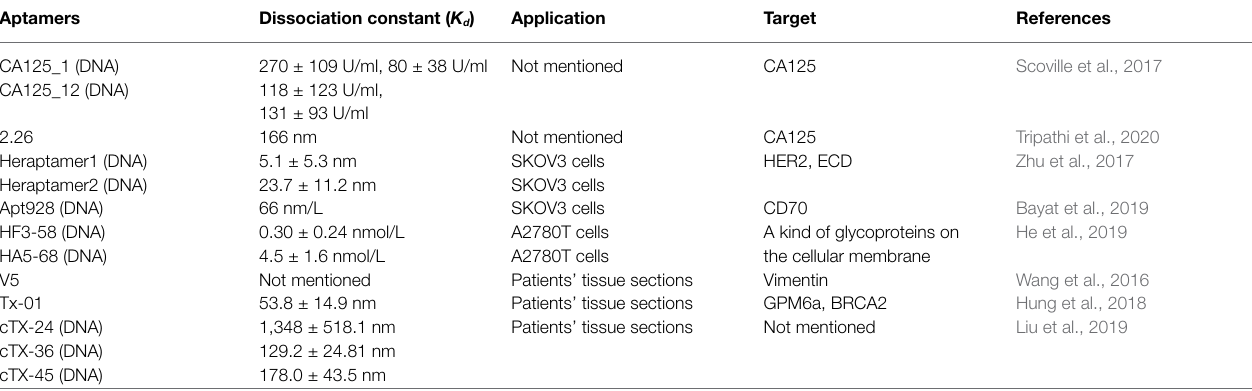
TABLE 1 | Newly screened aptamers targeting cancer-specific molecules and their